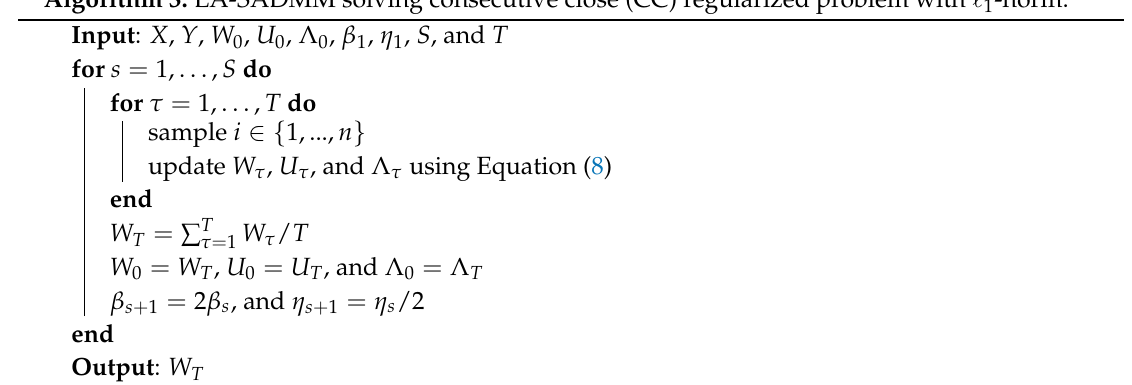
Algorithm 3: LA-SADMM solving consecutive close (CC) regularized problem with (cid:96) 1